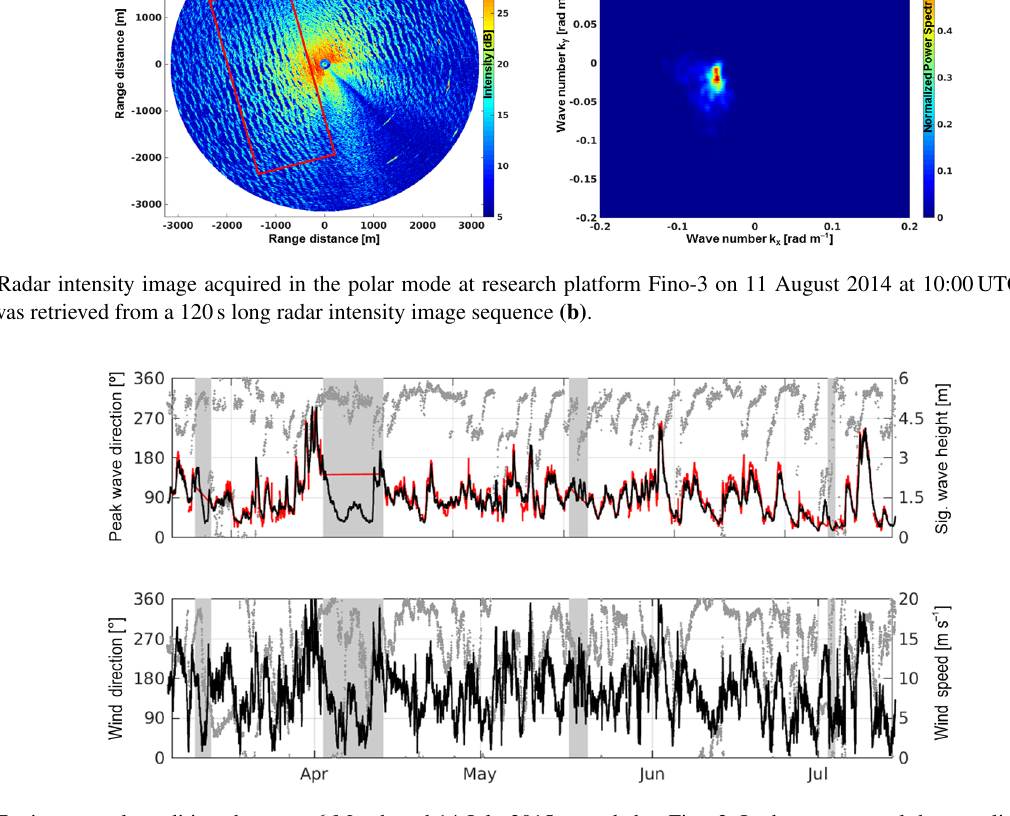
Figure 3. Environmental conditions between 6 March and 14 July 2015 recorded at Fino-3. In the upper panel the grey line represents the peak wave direction and the black and red lines significant wave height from the buoy and radar, respectively. In the lower panel the grey and black lines give the wind direction and wind